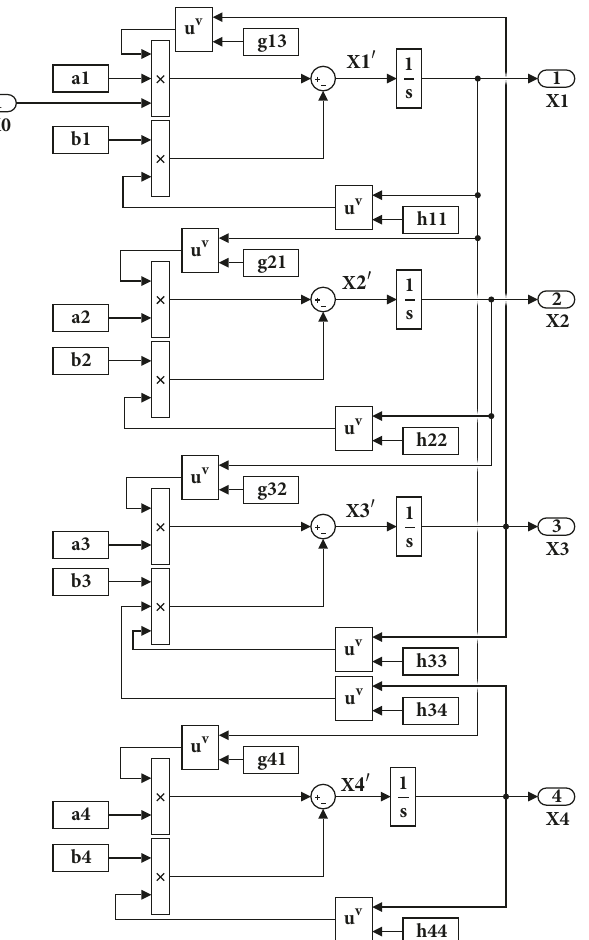
Figure 5: The block diagrams for the genetic branch pathway.